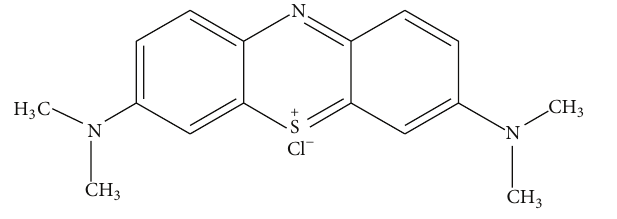
Figure 1: The structure of methylene blue (MB).